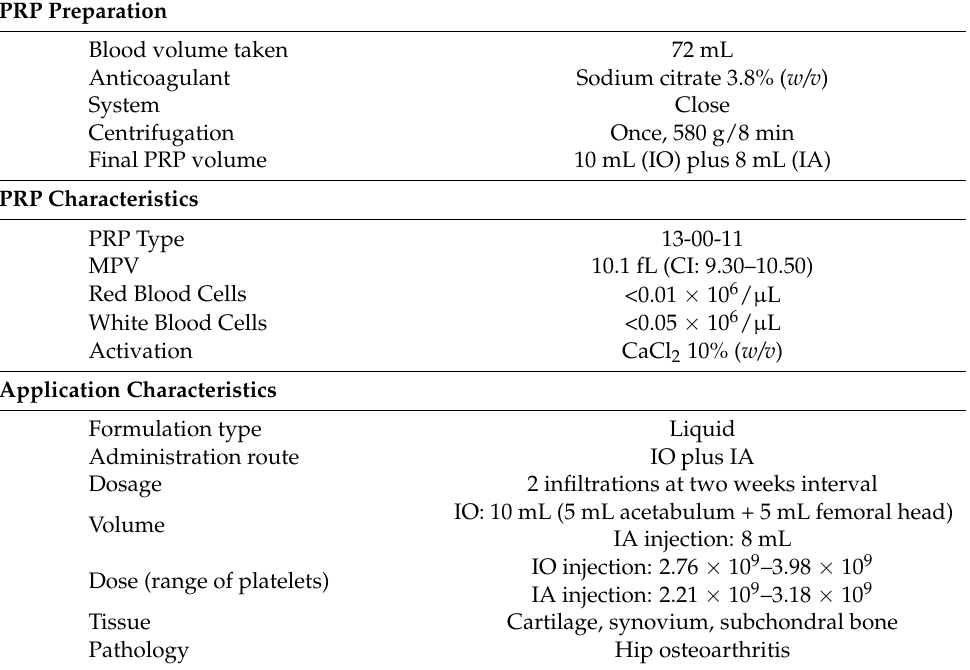
Table 2. The characteristics of patient derived PRP